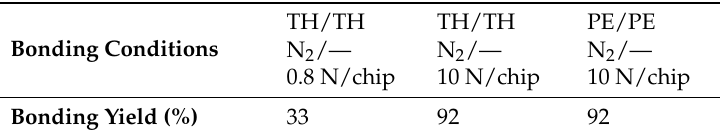
Table 1. Effect of oxide types and bonding load on bonding yields of chips directly bonded to wafers with N 2 plasma activation on